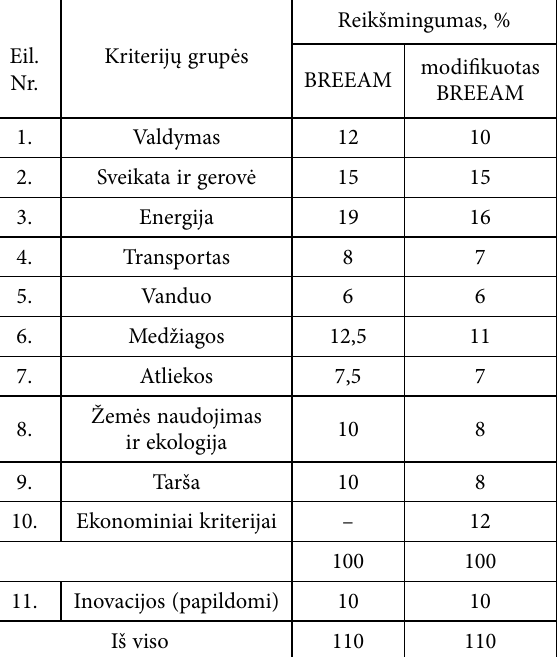
Table 1. Criteria sets of BREEAM and a modified method and their significances